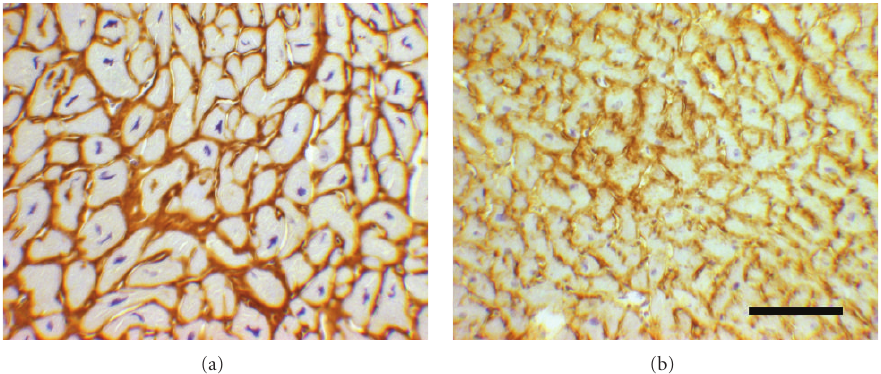
Figure 2: Sections of myocardium from patients with HCM (a) and control (b) stained for visualisation of HA. In HCM, there is marked cardiomyocyte hypertrophy and variation in cell size (a) compared with controls (b). The bar in B represents 100 µ